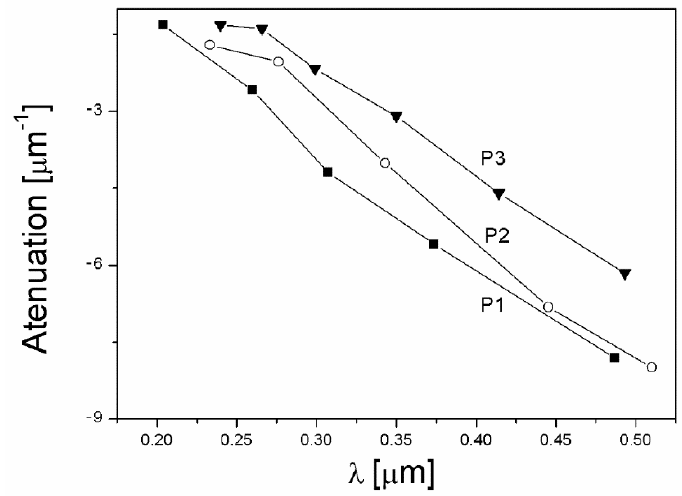
Figure 8. Spectral dependence of the scattering coefficient of porous SiO 2 films.